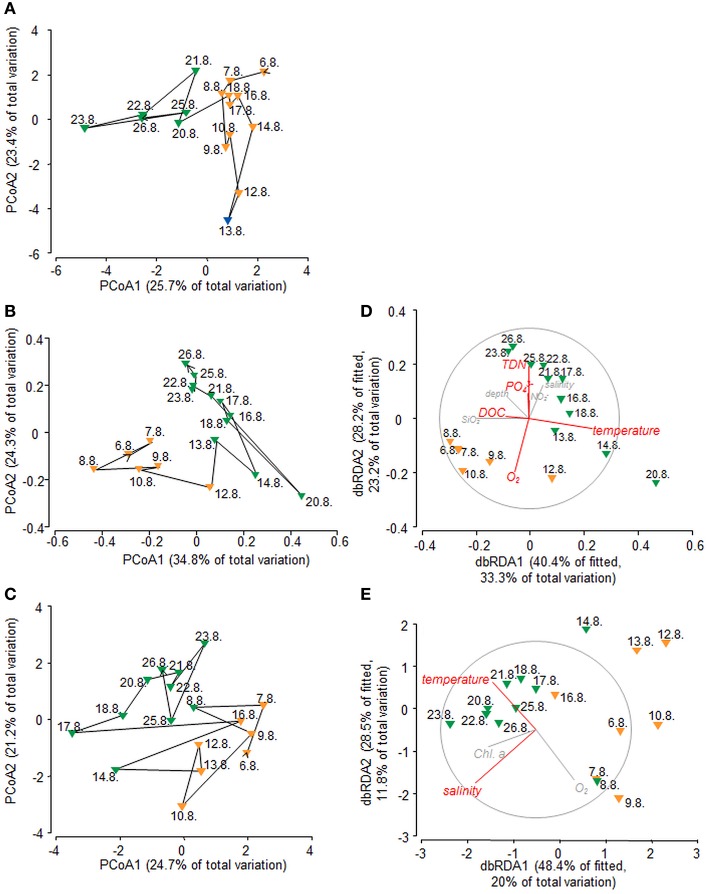
Principal coordinates analyses (PCoA) of (A) environmental variables based on Euclidean distance, (B) bacterial communities based on Hellinger distance, and (C) molecular DOM composition based on Bray-Curtis similarity. Distance-based redundancy analysis (dbRDA) of (D) bacterial communities and (E) DOM composition, both based on Bray-Curtis similarities. Environmental parameters explaining the variation significantly (p < 0.05) are depicted in red, non–significant parameters are depicted in gray. Color code refers to group formation according to k-R Clustering. Orange, group A; Green, group B; Blue, group C.